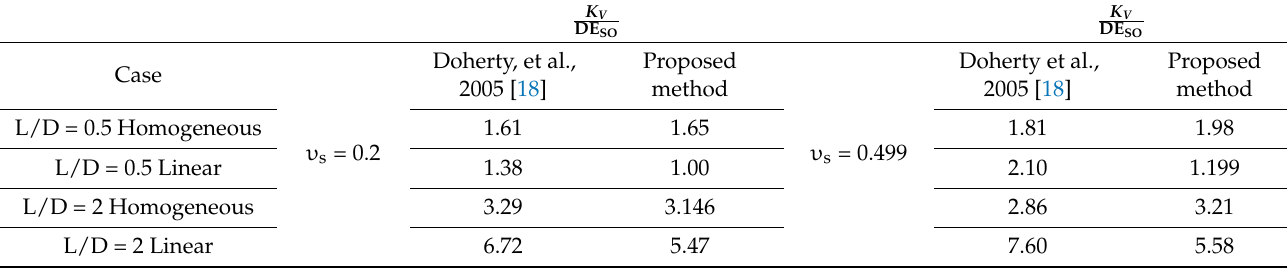
Table 3. Comparison of vertical stiffness at υ s = 0.2 and υ s = 0.499. Data from Doherty et al. (2005) [18].